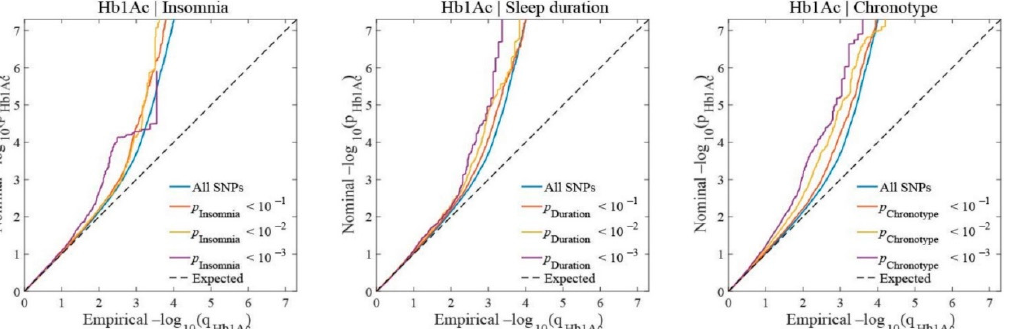
Figure 1. Polygenic overlap between diabetes-related traits (type 2 diabetes, fasting glucose, glycated hemoglobin, and fasting insulin) and sleep traits (insomnia symptoms, sleep duration, and chronotype). Conditional Q–Q plots of nominal versus empirical − log10 p -values (corrected for inflation) in type 2 diabetes, fasting glucose, glycated hemoglobin, and fasting insulin, below the standard genome-wide association study threshold of 5 × 10 − 8 as a function of significance of association with insomnia, sleep duration, and chronotype, respectively, at the level of − log10 ( p ) ≥ 1, − log10 ( p ) ≥ 2, and − log10 ( p ) ≥ 3, corresponding to p ≤ 0.10, p ≤ 0.01, and p ≤ 0.001, respectively. The blue lines indicate all SNPs. The dashed lines indicate the null hypothesis.